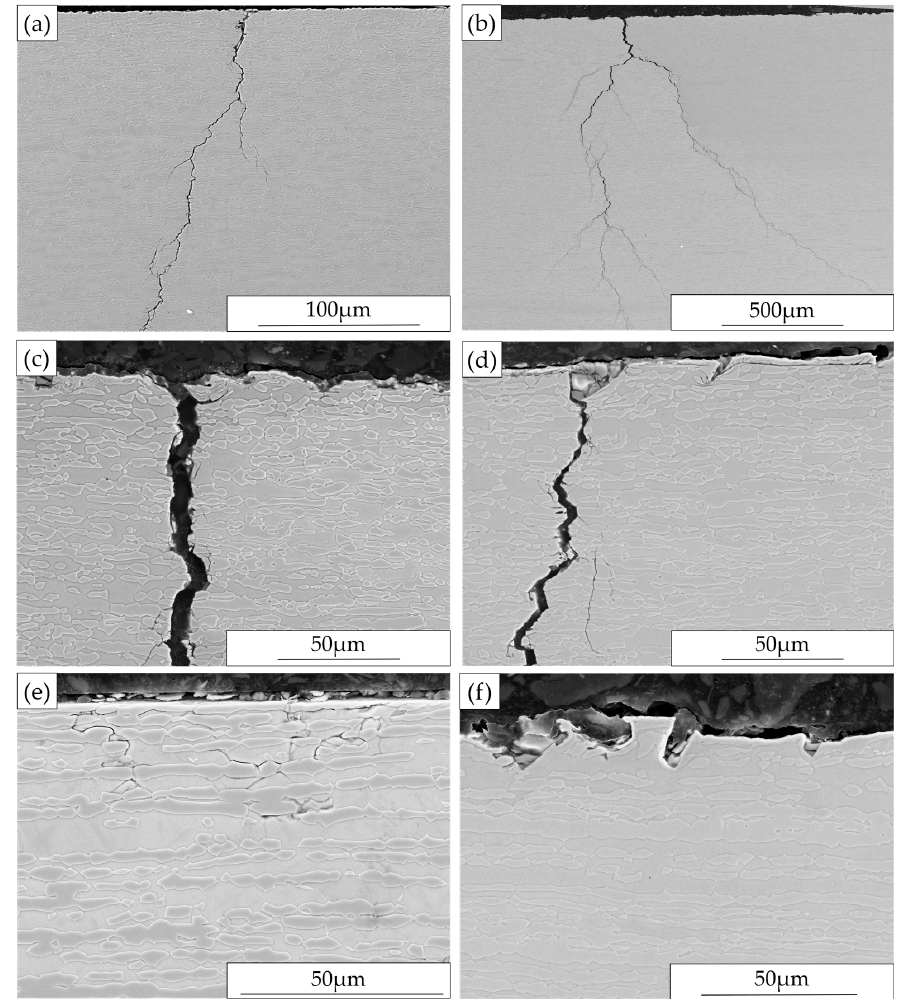
Figure 10. Cross-section microstructures showing stress corrosion cracking after exposure under four-point bend loading: ( a ) AD-TD specimen, 700 MPa, sectioned parallel to loading direction; ( b , c ) Ground-RD-TD specimen, 700 MPa, sectioned parallel to loading direction; ( d ) Ground-TD-TD specimen, 500 MPa, sectioned parallel to loading direction; ( e ) Ground-RD-TD specimen, 700 MPa, sectioned perpendicular to loading direction; and ( f ) Ground-RD-RD specimen, 900 MPa, sectioned parallel to loading direction.